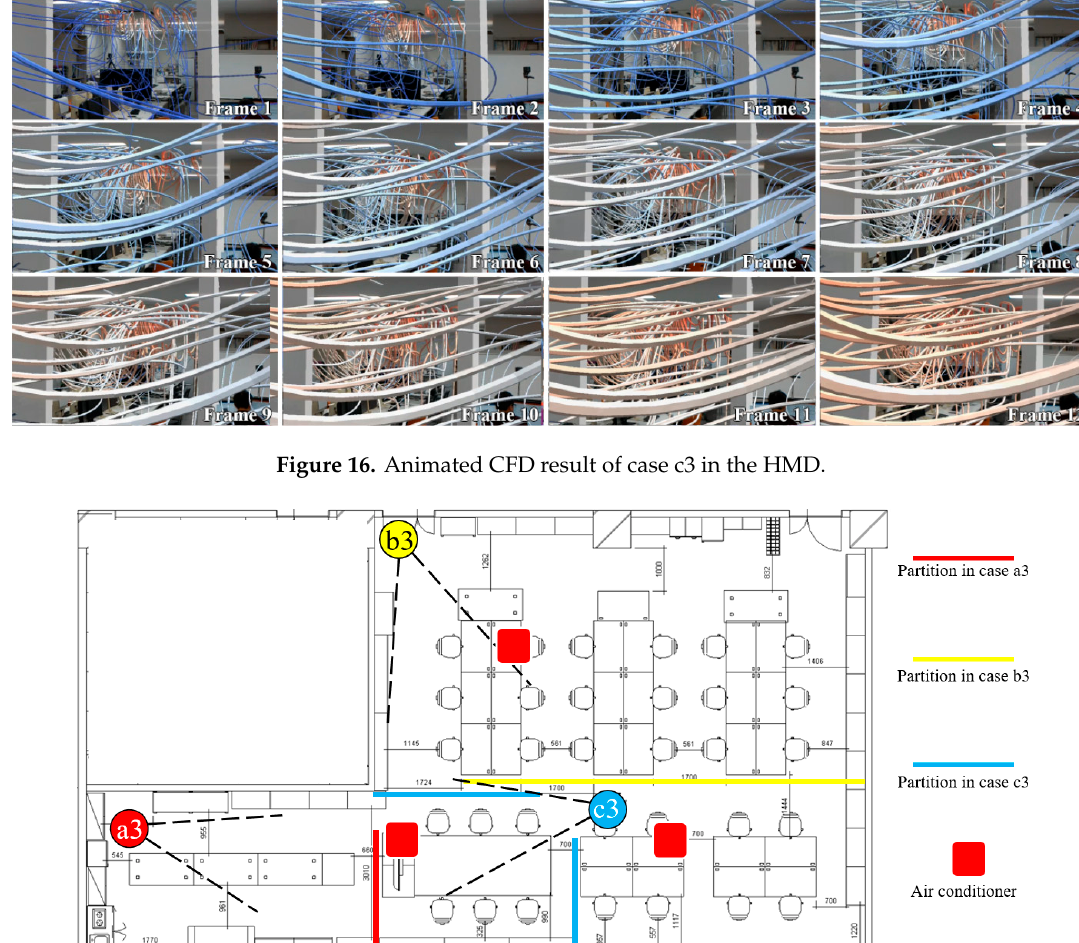
Figure 15. Animated CFD result of case b3 in the HMD.